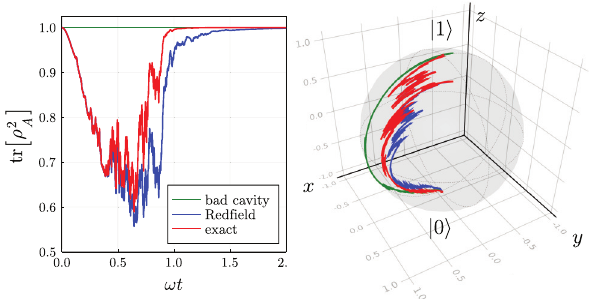
FIG. 2. Example of homodyning atomic trajectories for the Jaynes-Cummings model with g = 2 ω , (cid:2) = ω , and κ = 3 ω for different approximation schemes. Left: purity of the atomic state ] as a function of time obtained in the bad cavity limit [green tr[ ρ 2 A line, Eq. (7)], the Redfield limit [blue line, Eq. (5)], and the exact equation [red line, Eq. (4)]. As seen on the plot, in the bad cavity approximation the state is pure, which is not in agreement with the exact dynamics. Thus, in this approximation, the state of the atom remains on the Bloch sphere (right